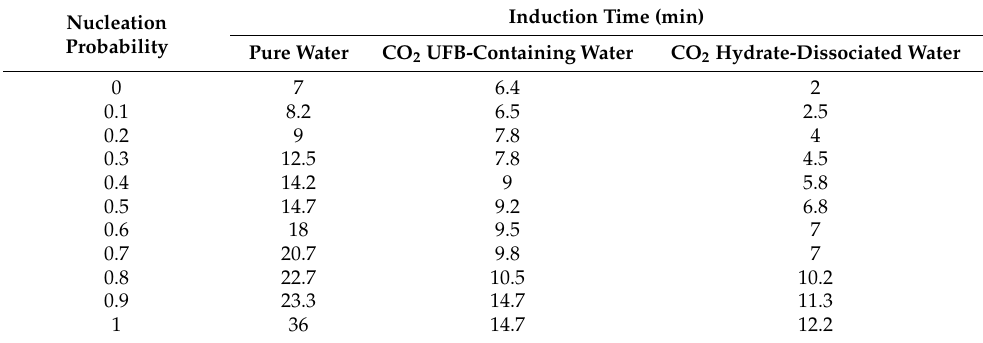
Table A1. Numerical data for Figure